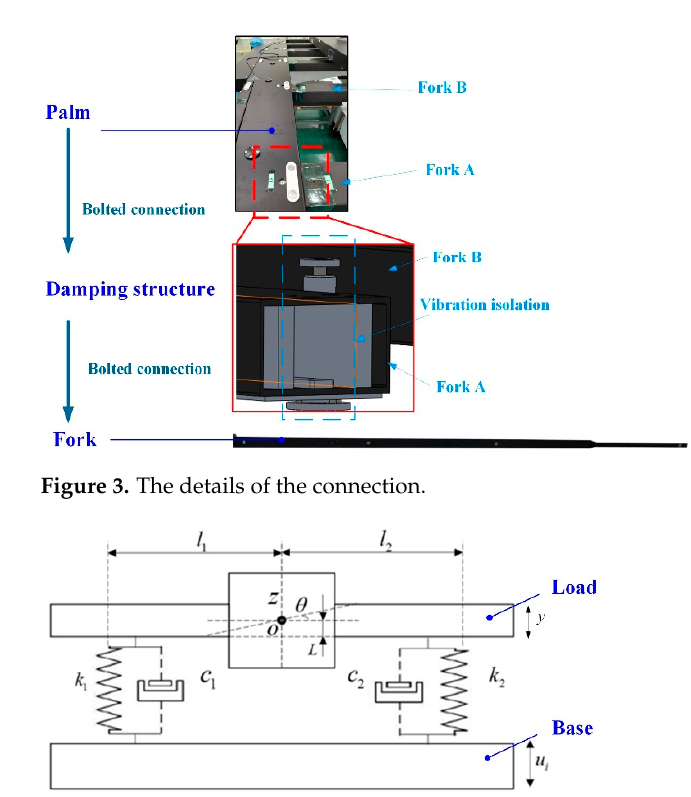
Figure 2. The construction of the end effector.